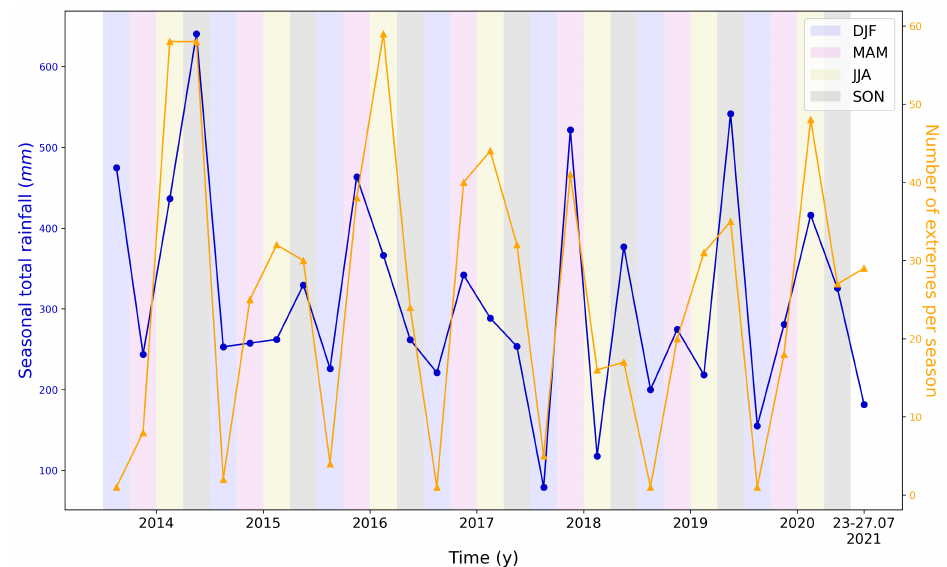
Figure 4. Total seasonal rainfall and the number of extreme events, for the period between 2014 and 2020 plus the 5 days of interest of 2021. DJF, MAM, JJA, and SON correspond to the initials